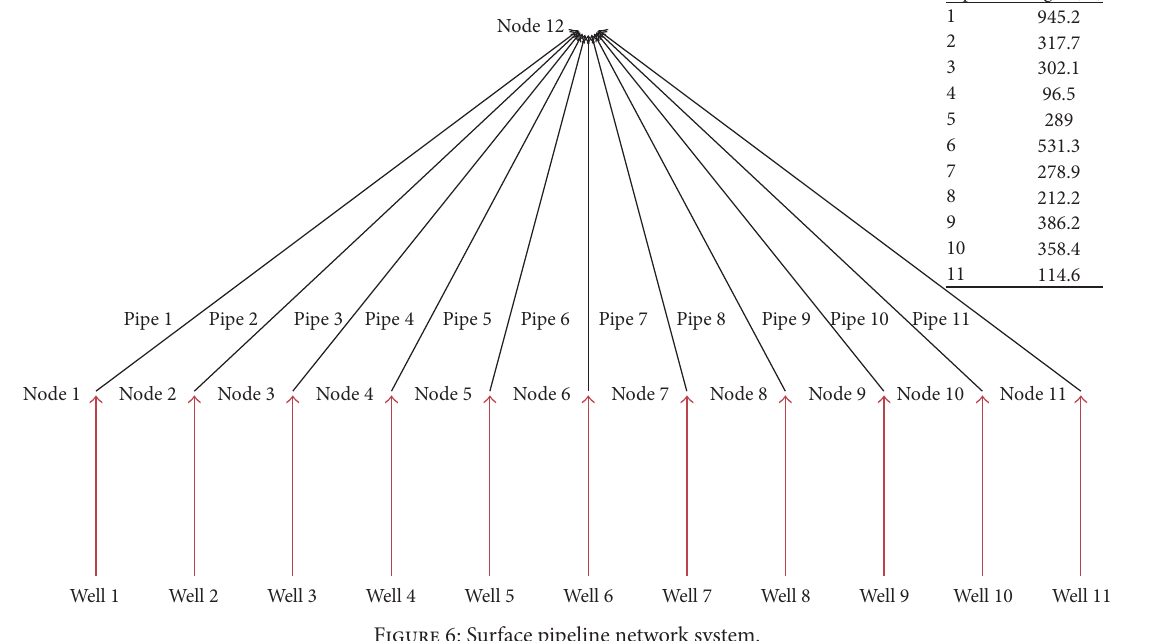
Figure 6: Surface pipeline network system. Table 1: Comparison of the four models.